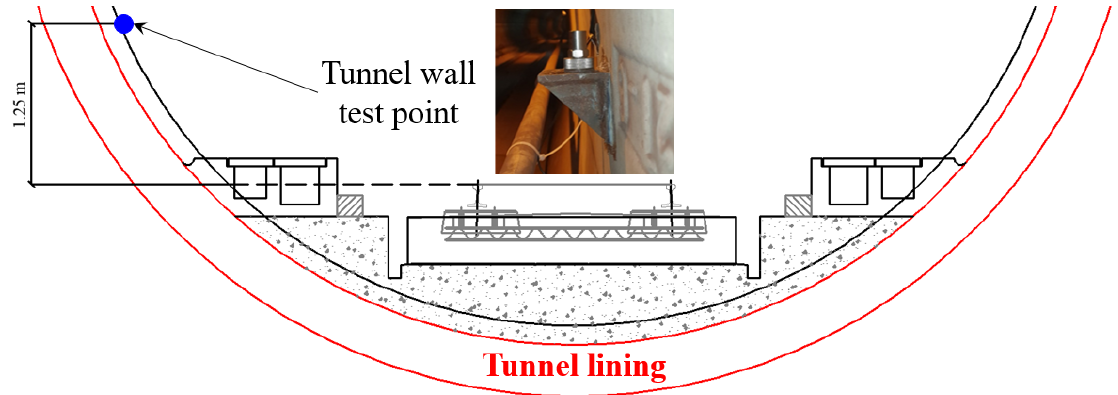
Figure 2. Setup of tunnel wall vibration test